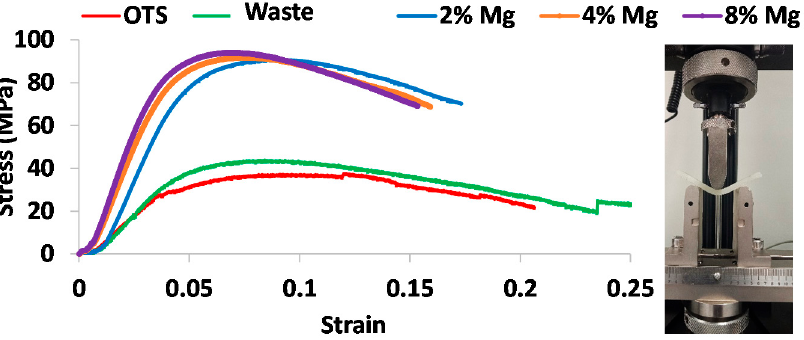
11 of 17 Figure 6. SEM imaging of tensile failure zones for: ( a ) OTS; ( b ) waste; ( c ) 2% Mg; ( d ) 4% Mg; ( e ) 8% Mg dog bone samples. 3.6. Flexural Properties Figure 7 shows flexural stress–strain profiles obtained from three-point bending tests for different printed samples. The flexural test provided the most interesting results, with the waste and OTS exhibiting a similar trend of stress–strain curves, while the curves for Mg composites shifted upward. As summarized in Table 5, both the flexural strength and Young’s modulus for the waste nylon increased by 13% (from 30.91 to 34.81 MPa) and by 26% (from 202.59 to 255.8 MPa), respectively, when compared with that of OTS. As shown in Table 5, with the increase of Mg percentage, both the flexural strength and Young’s modulus for the composites increased. For example, the flexural strength for 2% Mg was 3 times greater than the waste, increasing to 3 times higher for the 8% Mg, reaching about 96 MPa. Similarly, the flexural modulus for 2% Mg was 4 times the waste, increasing to 6 times with 8% Mg, reaching about 1397 MPa. These results clearly show that even a small percentage of Mg addition into the nylon matrix drastically enhances the flexural strength